Question: Generate an informative caption for the figure above.
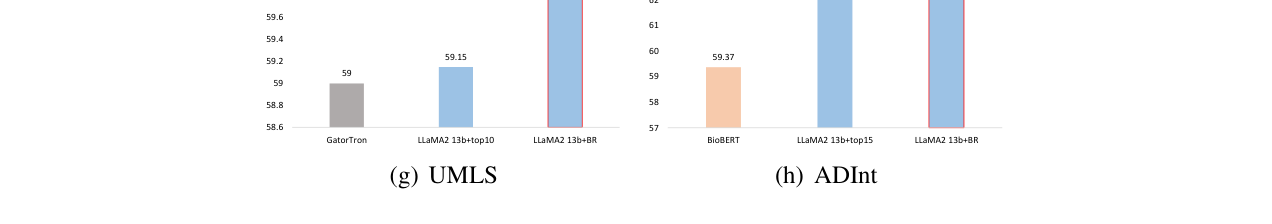
Answer: F1(a-h)/Accuracy(i) performance of different models. BR refers to BIOMEDRAG. The red font indicates the performance of BIOMEDRAG.